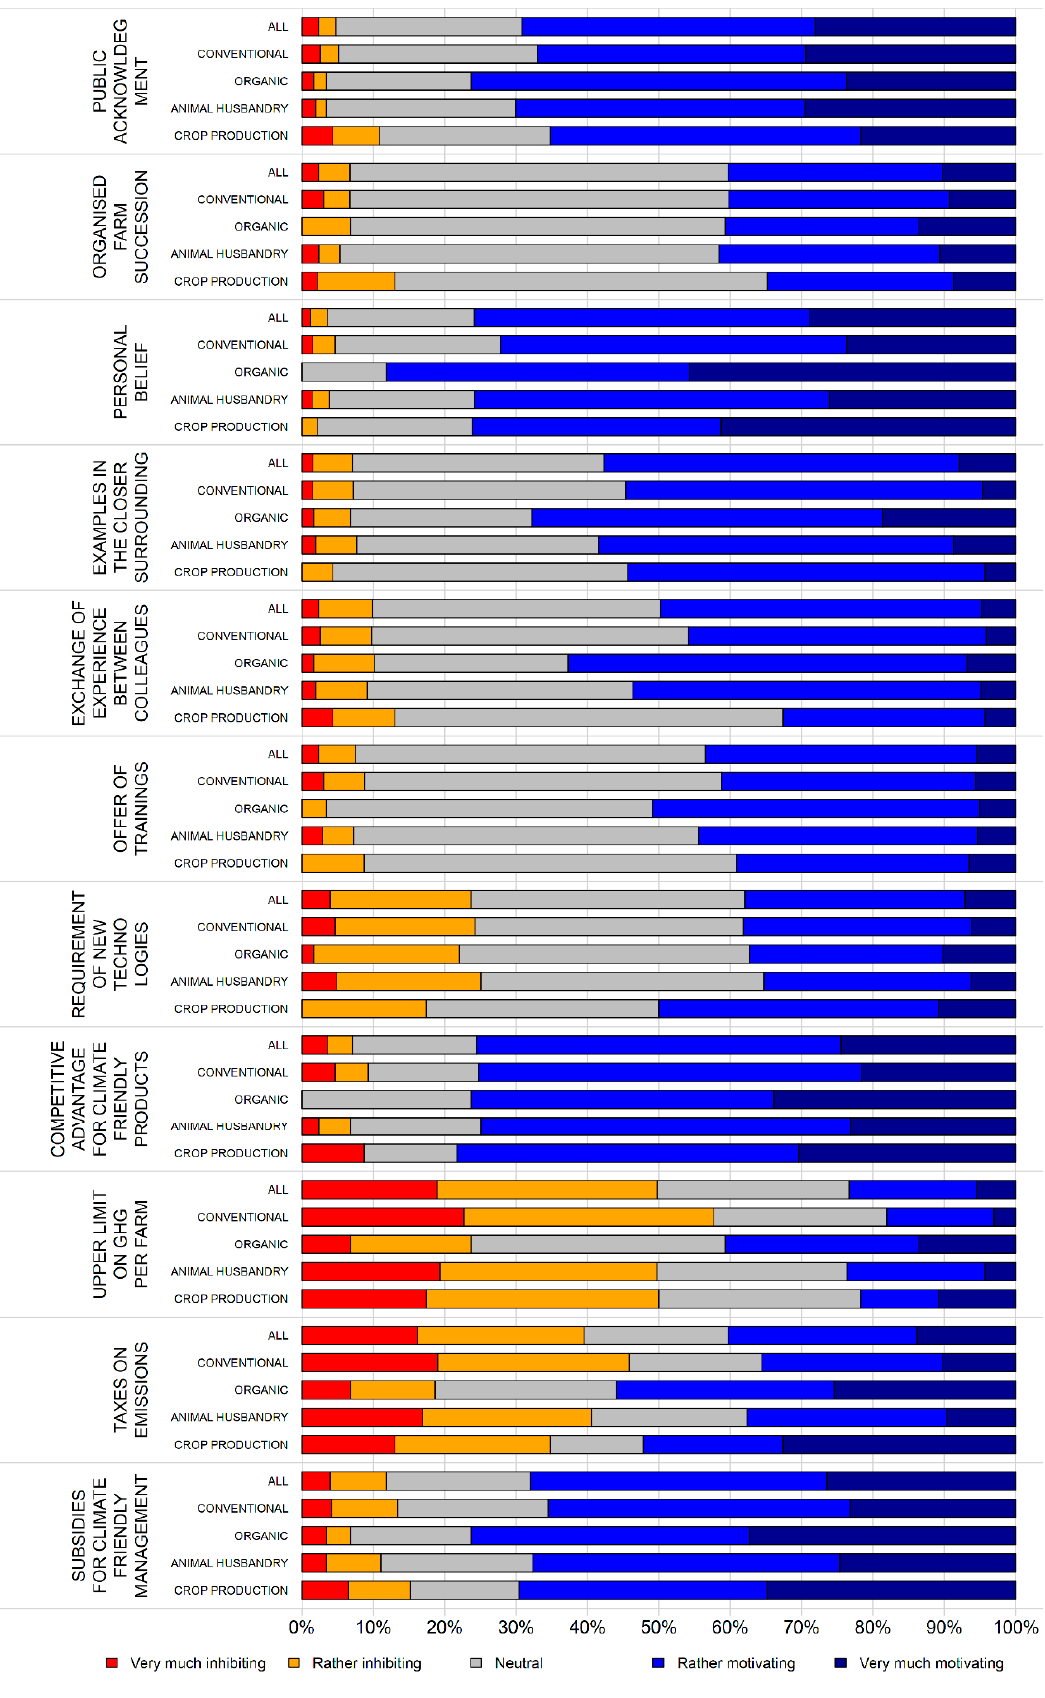
Figure 2. Motivating factors for reducing on-farm GHG emissions.